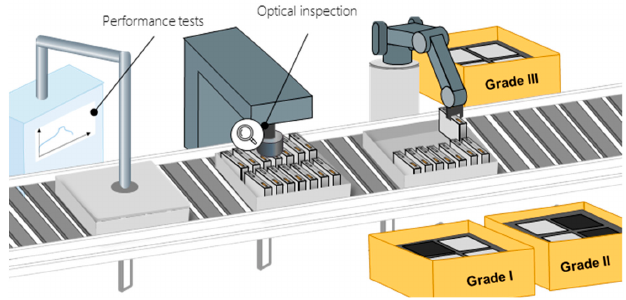
Figure 8 . Schematic of EoL testing and grading [9] . Figure 8. Schematic of EoL testing and grading